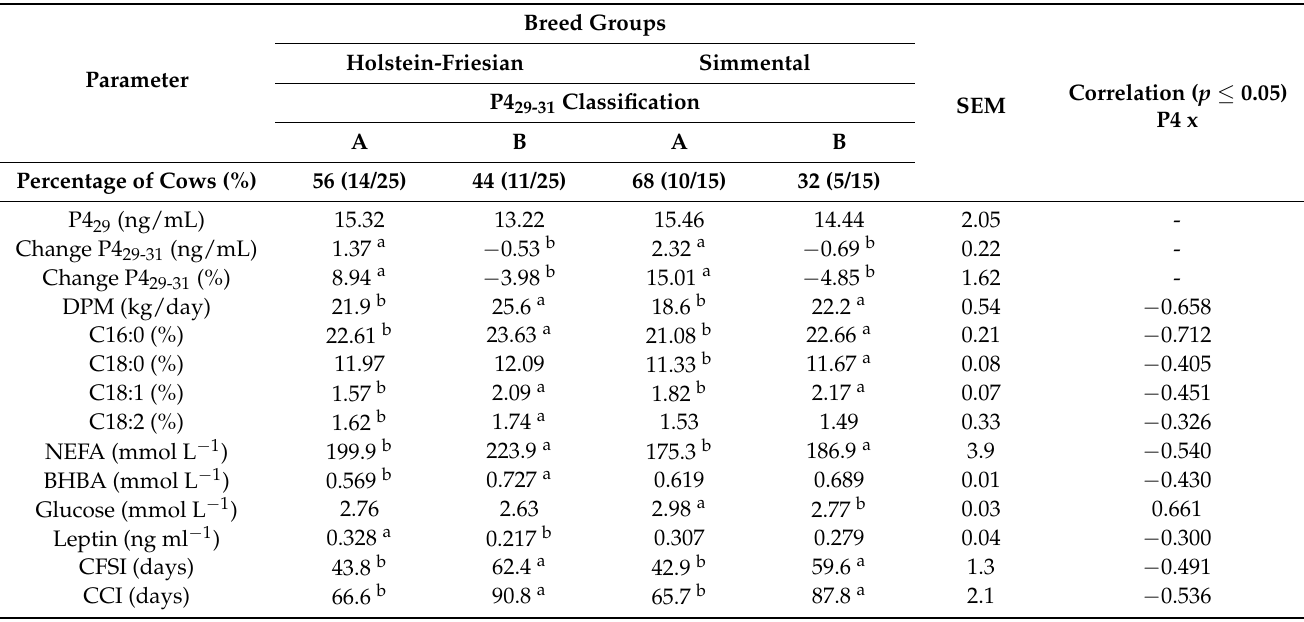
Table 3. Changes in indicators of NEB and fertility depending on classification to groups A and B according to the degree of changes in average progesterone (P4) levels between 29 and 31 days postpartum (P4 29-31